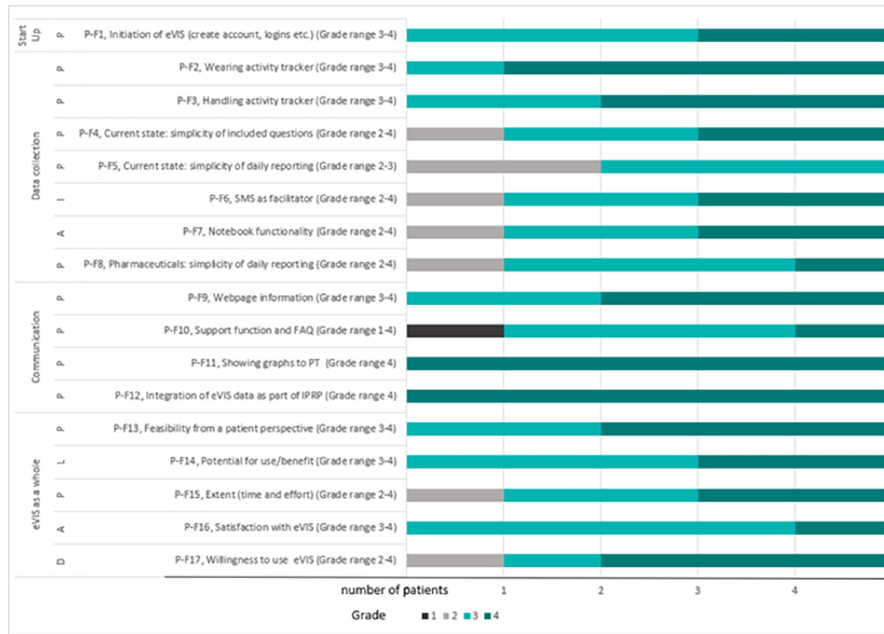
Fig 3. Evaluation of feasibility in a clinical context. Ratings post IPRP by patients (n = 5). Domain-specific explications of grades 1: Not at all, 2: To some extent, 3: To a rather large extent, 4: To a large extent. Item P-F17 was rated as extent of agreement with a statement from 1: Strongly disagree to 4: Strongly agree. Ratings � 3 = satisfactory feasibility. Abbreviations: IPRP = Interdisciplinary pain rehabilitation program, P = Practicality, I = Implementation, A = Acceptability, L = Limited Efficacy testing, D =